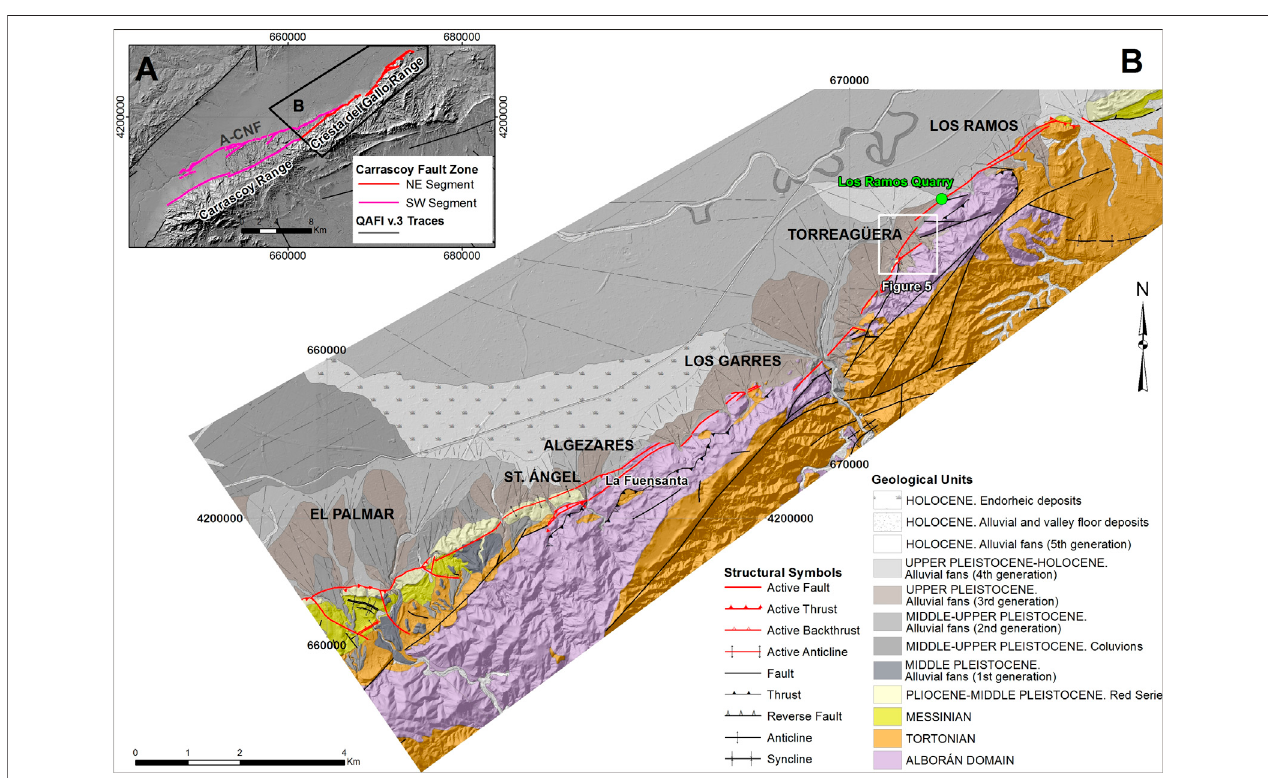
FIGURE 2 | (A) The Carrascoy Fault Zone de fi ned in Martín-Banda et al. (2015): SW Segment in pink color (A-CNF: Algezares-Casas Nuevas Fault) and NE Segmentinredcolor. (B) DetailedgeologicalcartographyoftheNESegmentoftheCarrascoyFaultmarkedinFigureAbytheblackpolygon.LocationoftheLosRamos quarry (green circle) and the Torreagüera alluvial fans (white square) are